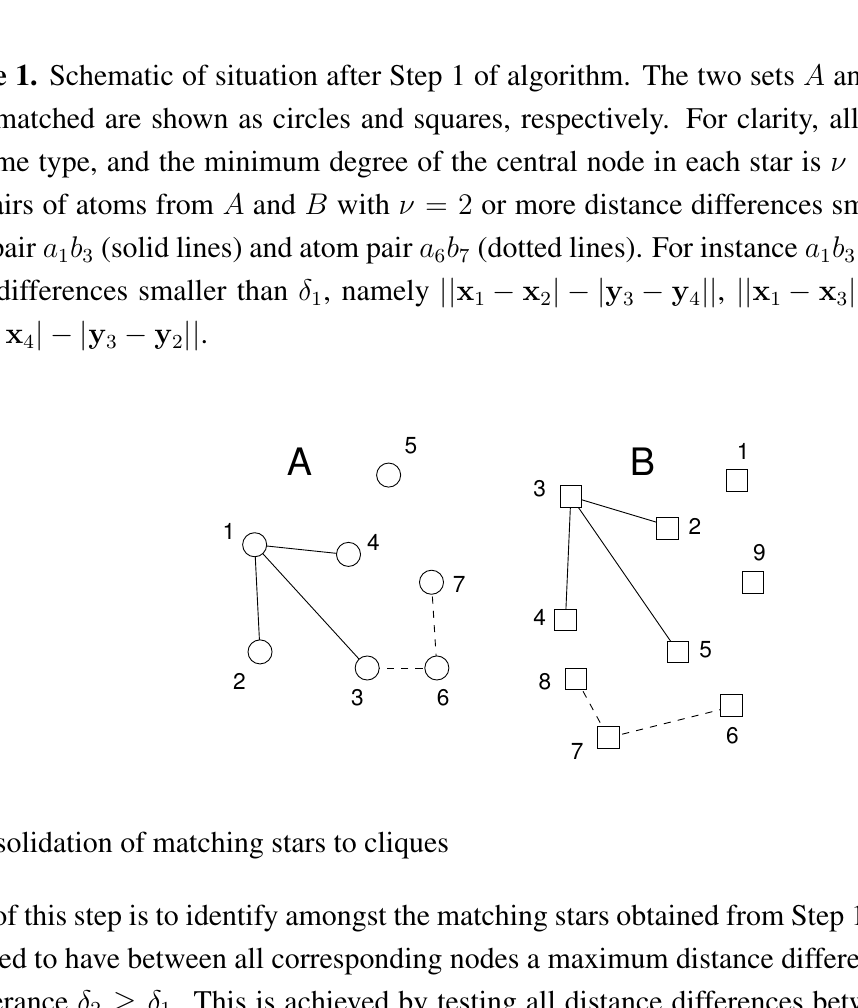
b (dotted lines). For instance a 6 7